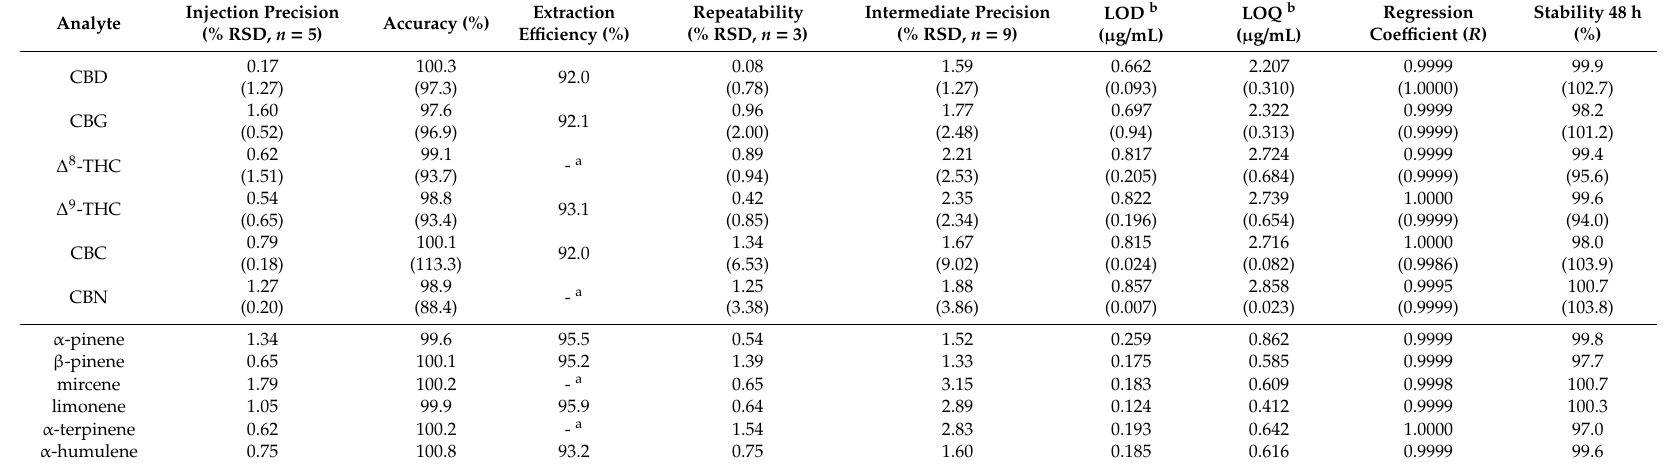
Table 1. Method validation